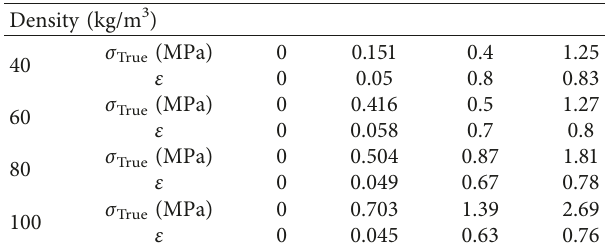
Figure 15: Effect of the foam density ( h 1.6mm, and t w Table 5: Stress-strain data points of PU foam with different densities